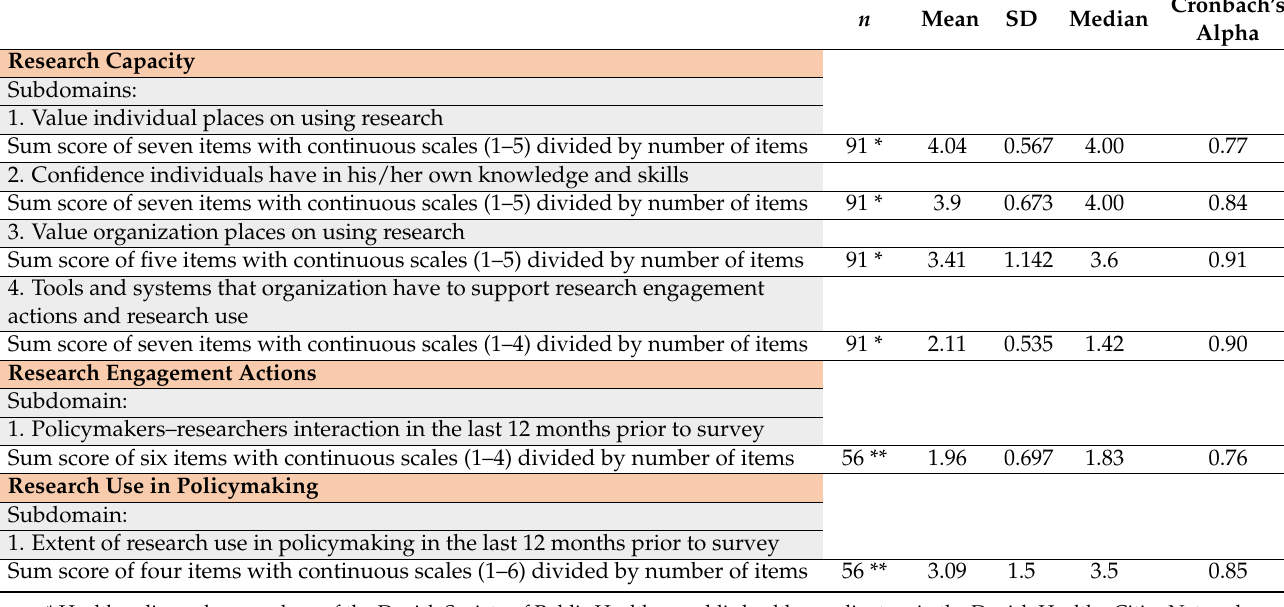
Table 2. Research Capacity, Research Engagement Actions and Research Use in Means, Standard Deviations (SD), Medians, Cronbach’ Alpha’s ( n = number of